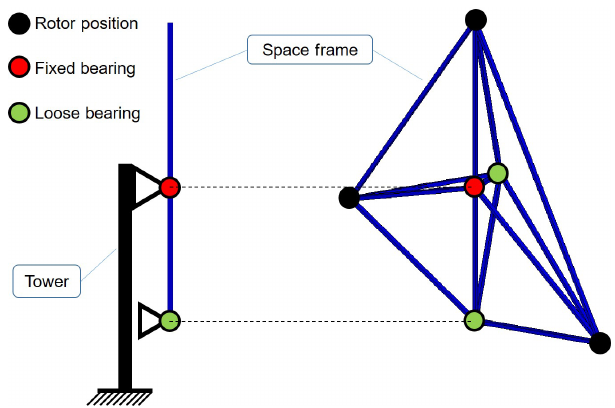
Figure 2. Tower and space frame connection via yaw